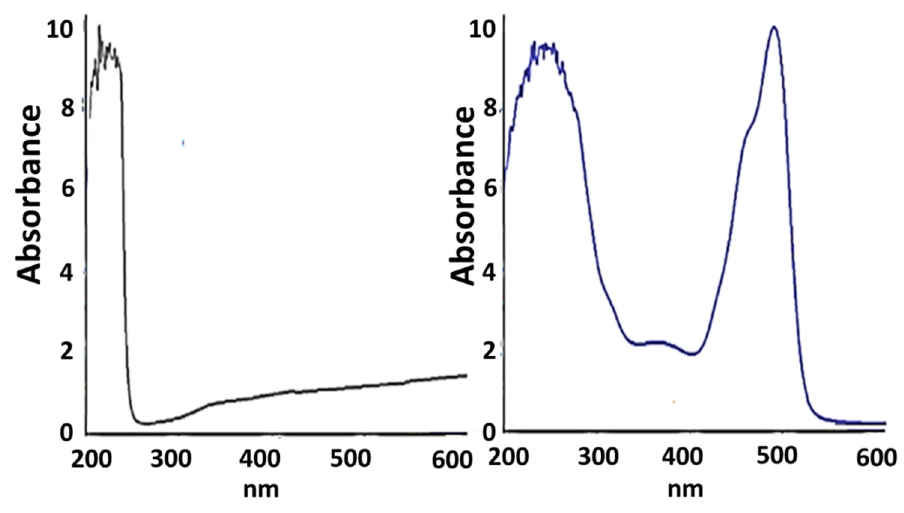
/ VIS spectrum of compound III ( left ) and compound IV ( right Figure 6. UV/VIS spectrum of compound III (left) and compound IV (right) . Figure 6. UV